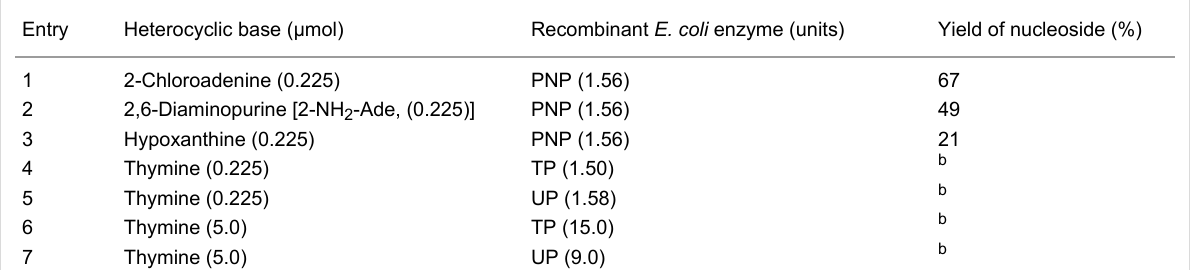
Table 1: Enzymatic condensation of purine and pyrimidine bases with 2-deoxy-2-fluoro- α -D-arabinofuranose-1-phosphate ( 12a ) catalyzed by the recombinant E. coli nucleoside phosphorylases.